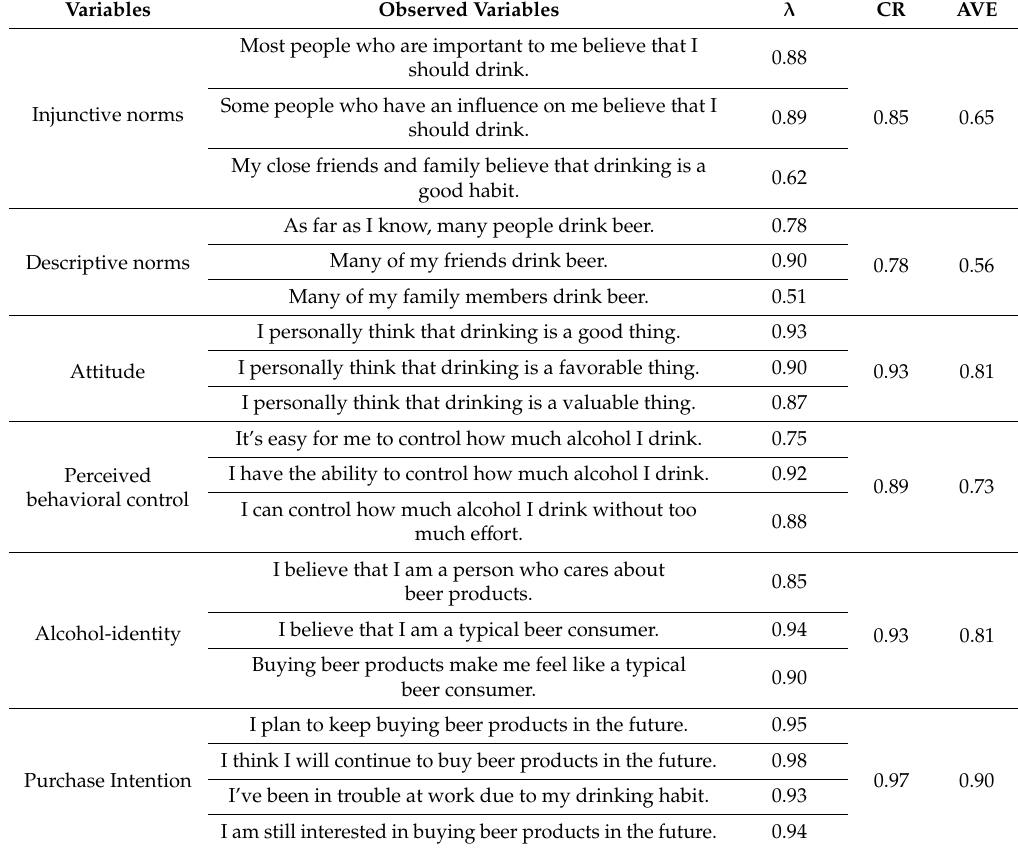
Table 2. Convergent validity test results.